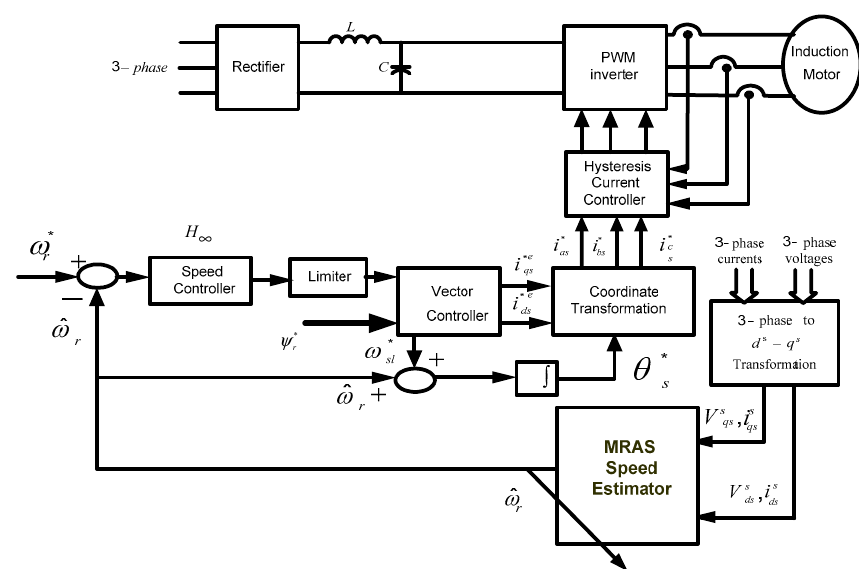
Figure 8. The block diagram of the proposed sensorless induction motor drive based on H ∞ theory.